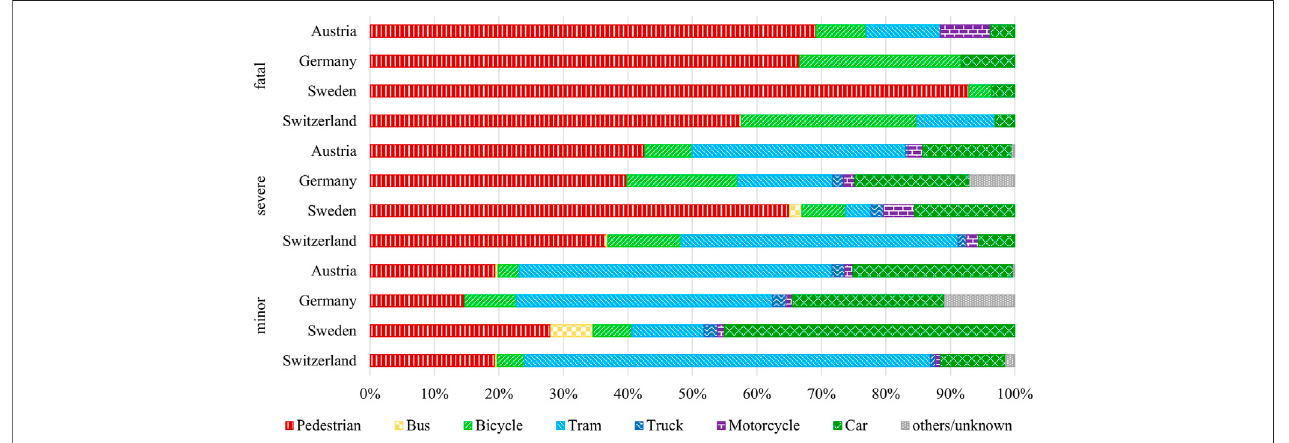
FIGURE 2 | Injured people classi fi ed by road use and severity (8,802 injured people).